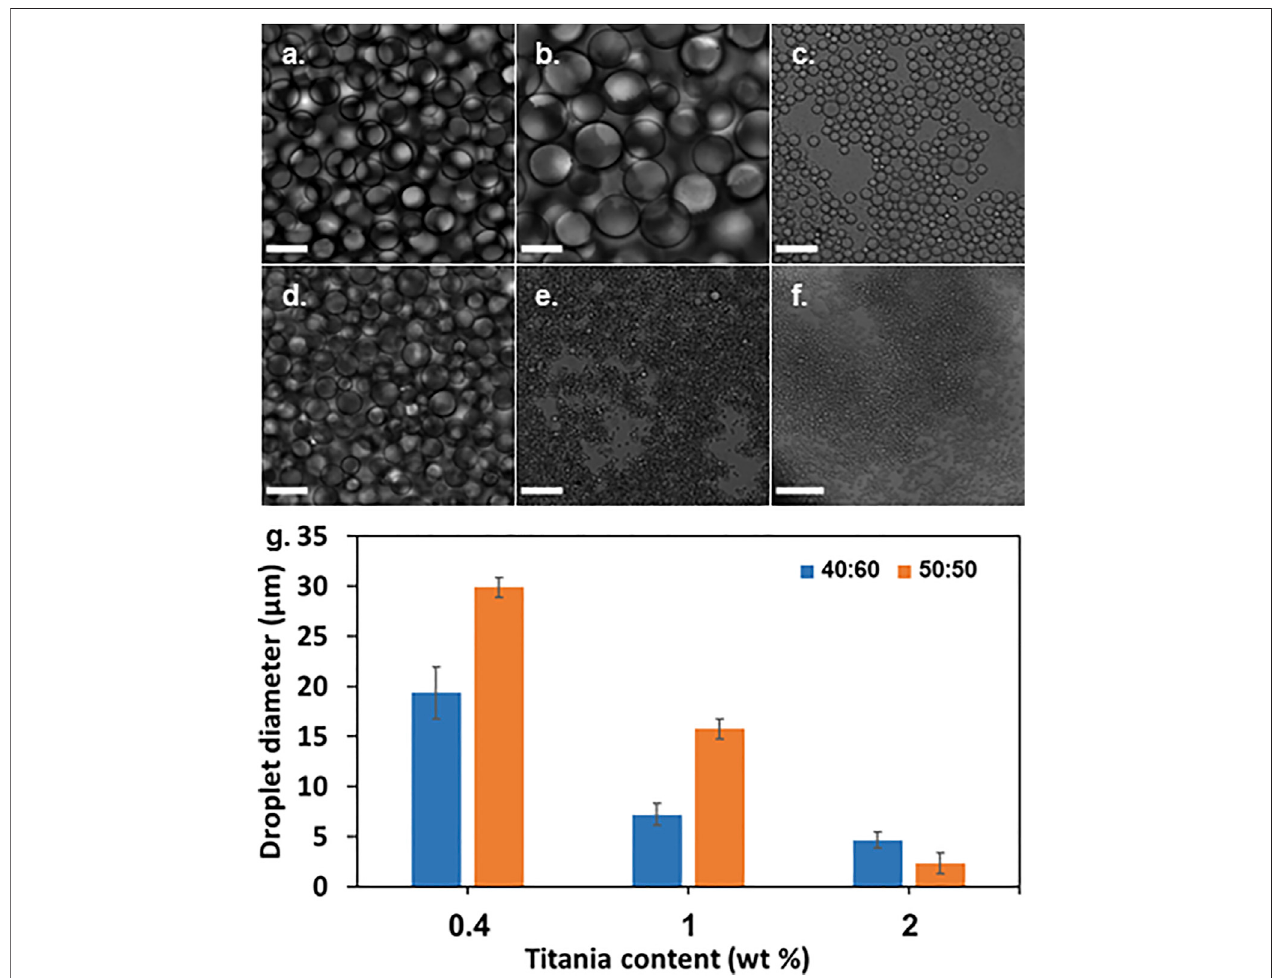
FIGURE1| Pickeringemulsionswith0.4,1,and2wt%titania-NH 2 contentatdifferentoil/waterratios. (A) 40:60,0.4wt%. (B) 50:50,0.4wt%. (C) 40:60,1wt%. (D) 50:50, 1wt%. (E) 40:60, 2wt%. (F) 50:50, 2wt%. (G) Droplet diameter as a function of titania-NH 2 content (wt%) and oil percentages in the emulsion (vol%). Scale bar is 30